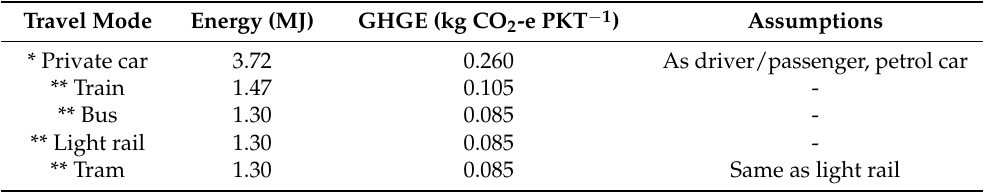
Table 2. Energy consumptions and GHGE factors for various travel modes.